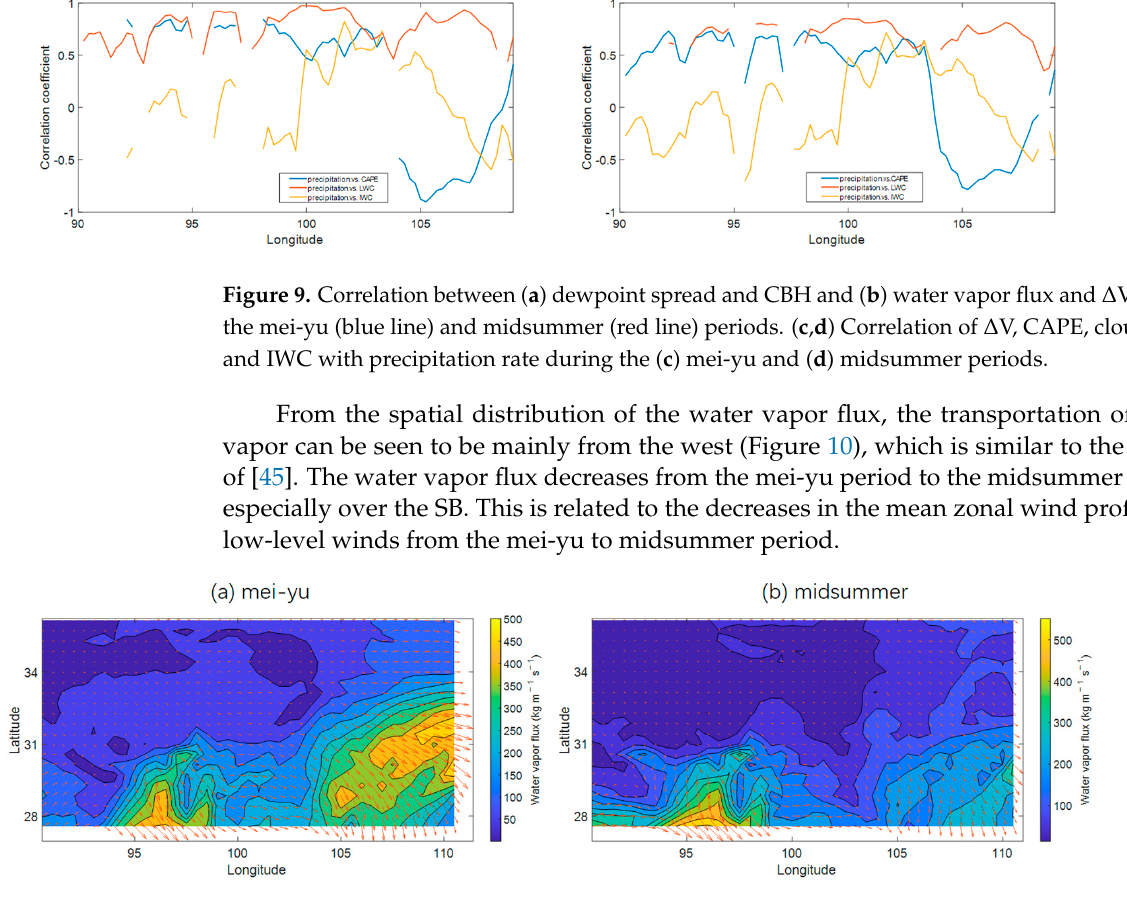
Figure 10. Integral of water vapor flux at 1800 LT from ERA5 over the ( a ) mei-yu and ( b ) midsum- mer periods.